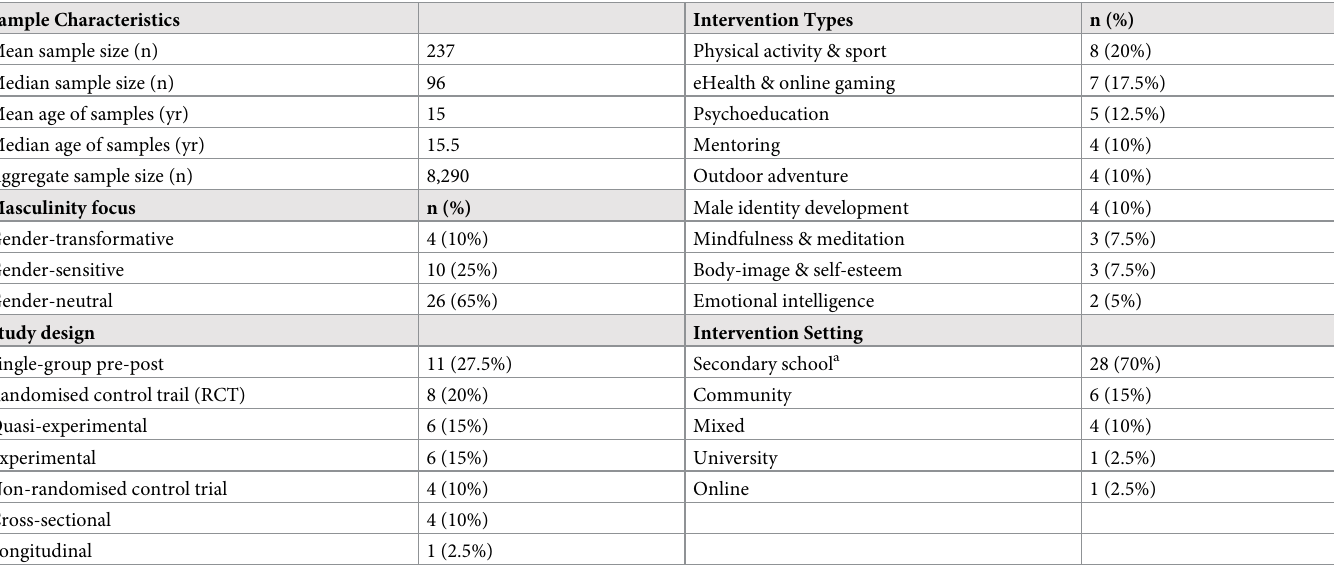
Table 3. Summarised article